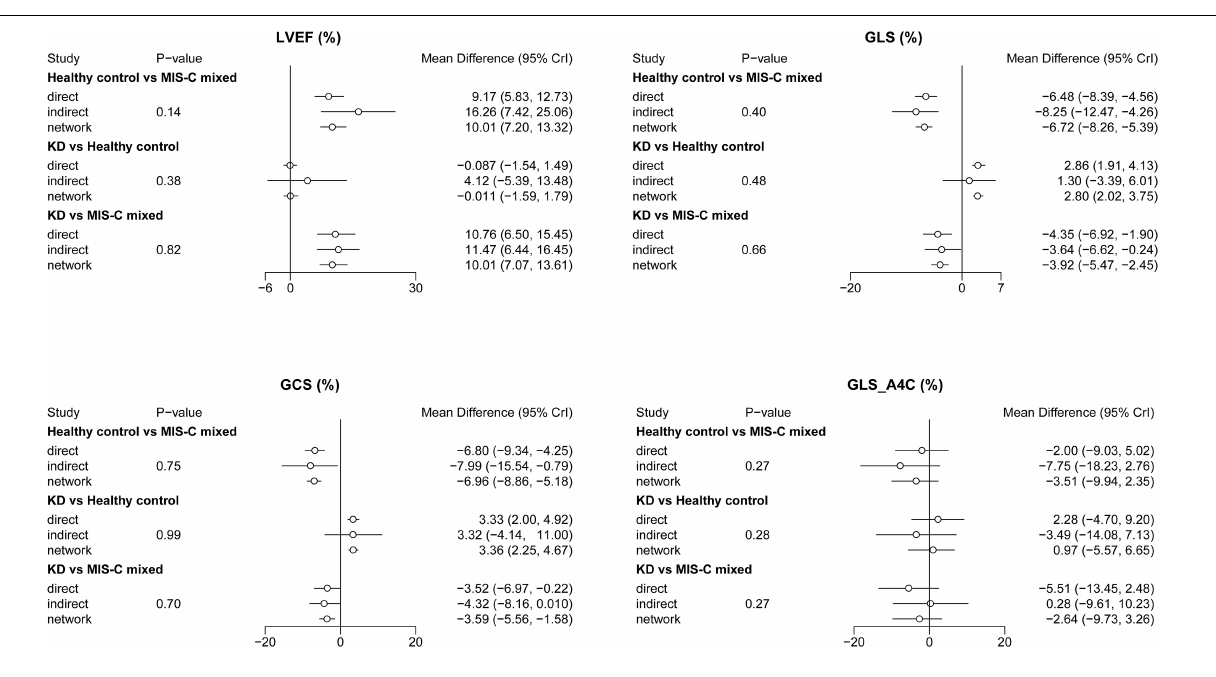
FIGURE 4 | Inconsistency test of network meta-analysis. GCS, global circumferential strain; GLS, global longitudinal strain; GLS_A4C, global longitudinal strain_apical four-chamber; KD, Kawasaki disease; LVEF, left ventricular ejection fraction; MIS-C, multisystem inflammatory syndrome in